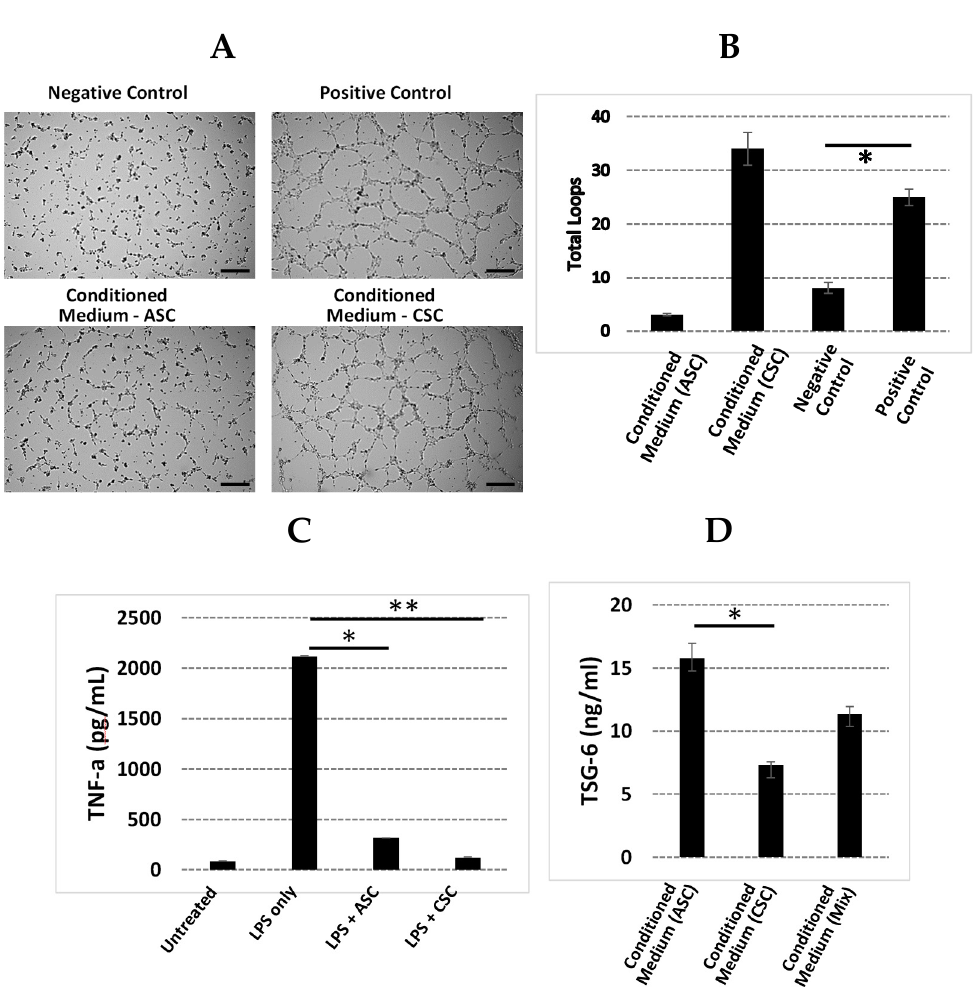
Figure 4. Angiogenic and anti-inflammatory functions of ASCs and CSCs. ( A ) Factors secreted by CSCs induced angiogenesis. The conditioned media collected from in vitro cultured ASCs and CSCs were used for the tube formation assay. Negative control: no serum medium; positive control: medium containing 5% fetal bovine serum (FBS). Representative images of tube formation are shown. Scale bar = 500 μ M. ( B ) Quantitative loops were counted, and the averages of three experimental repeats are shown. ( C ) ASCs and CSCs showed an anti-inflammatory function. THP-1 cells were treated with lipopolysaccharide (LPS) in the presence or absence of ASCs and CSCs for 48 h. The collected medium was used to detect the level of TNF-a with ELISA. Non-LPS-treated samples were used as a negative control. ( D ) ASCs secreted higher levels of TSG-6 than CSCs. The conditioned media collected from the cultured ASCs and CSCs were used for TSG-6 anal- ysis with ELISA. Error bar = standard deviation. * p < 0.05; ** p < 0.001.